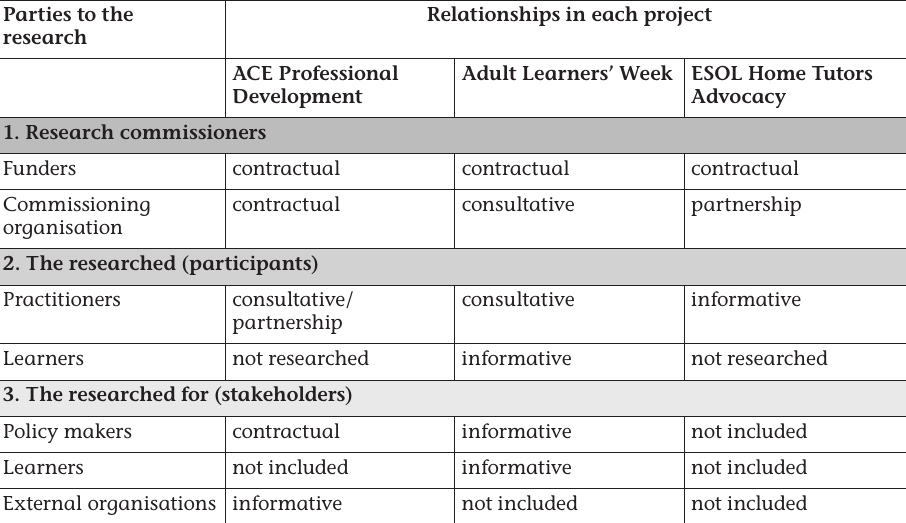
Table 1: An analysis of each project in terms of relationships with the parties to the